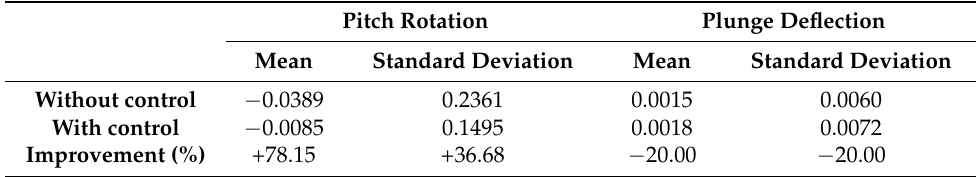
Table 3. Statistics of the aeroelastic response induced by atmospheric